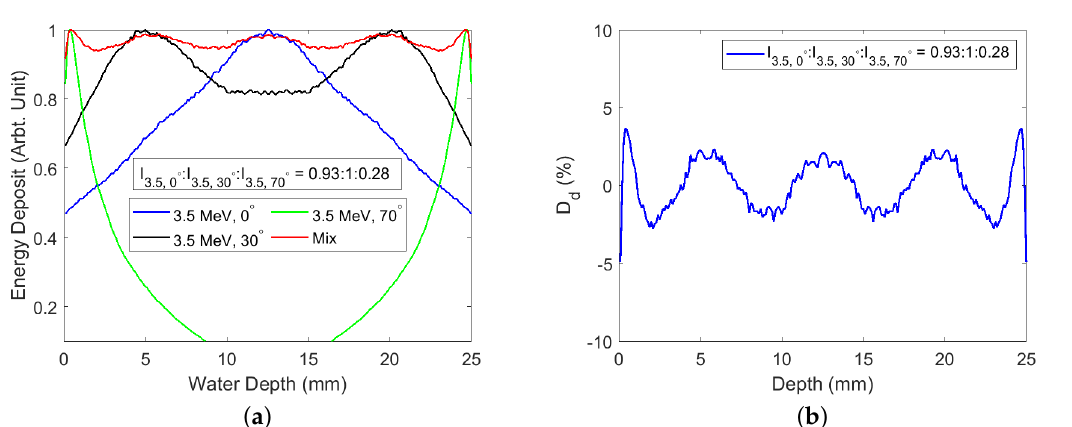
Figure 13. ( a ) Dose deposition curves for different angles of incidence, and ( b ) the corresponding dose deviation of a 3.5 MeV beam. I is the beam intensity as given in Equation (24).